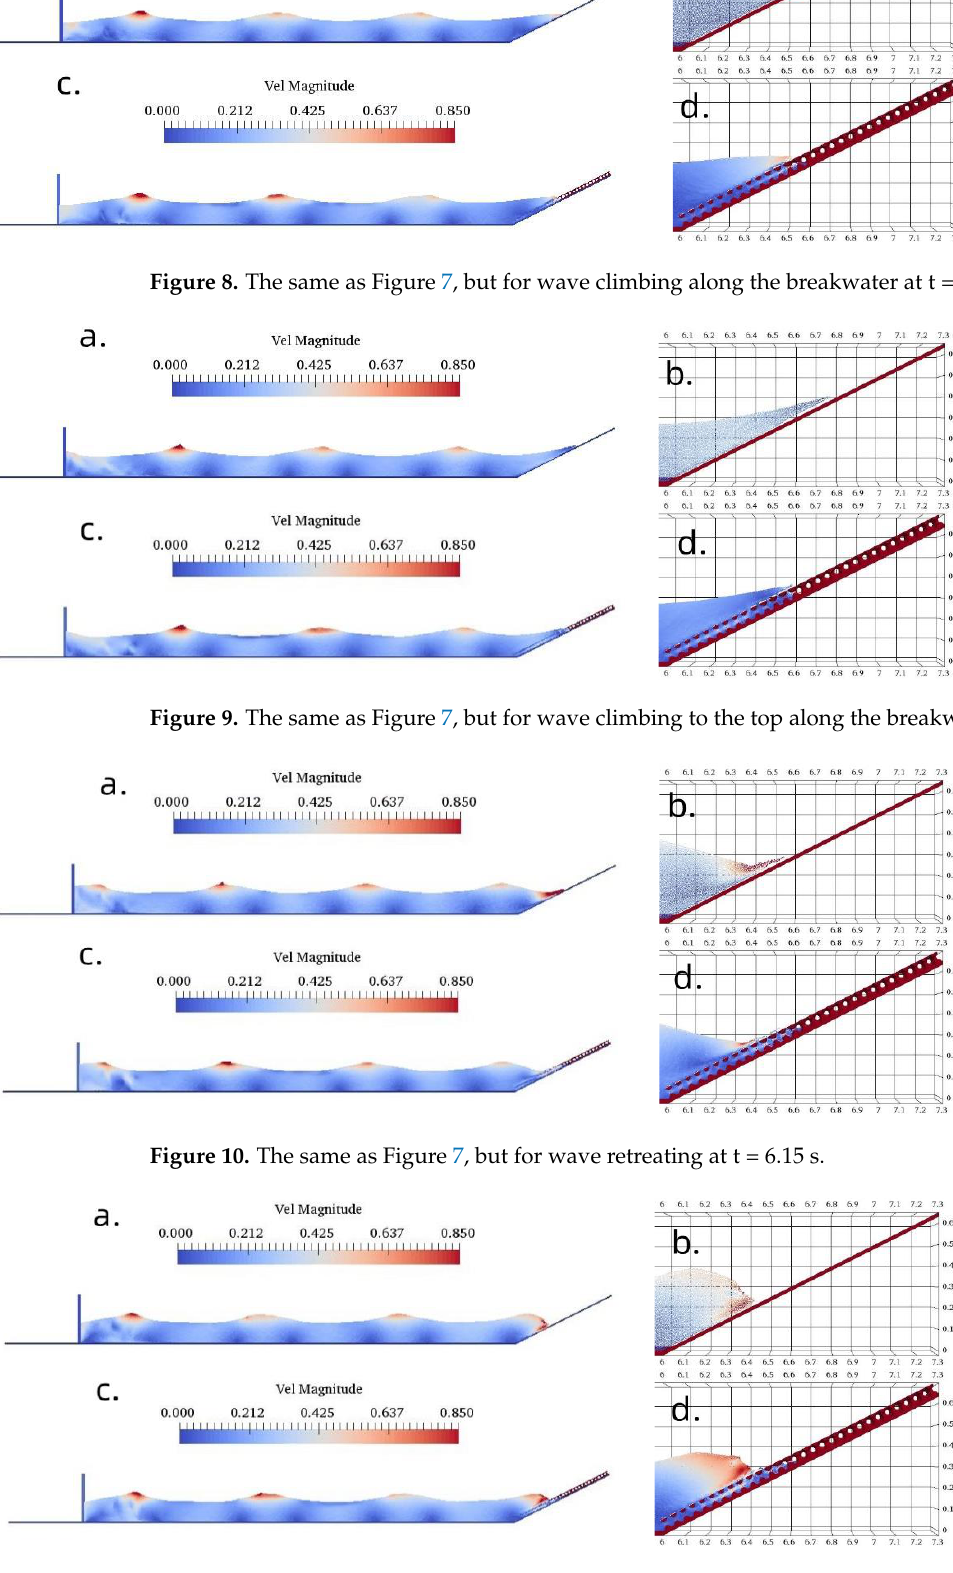
Figure 11. The same as Figure 7, but for wave breaking at t = 6.45 s.